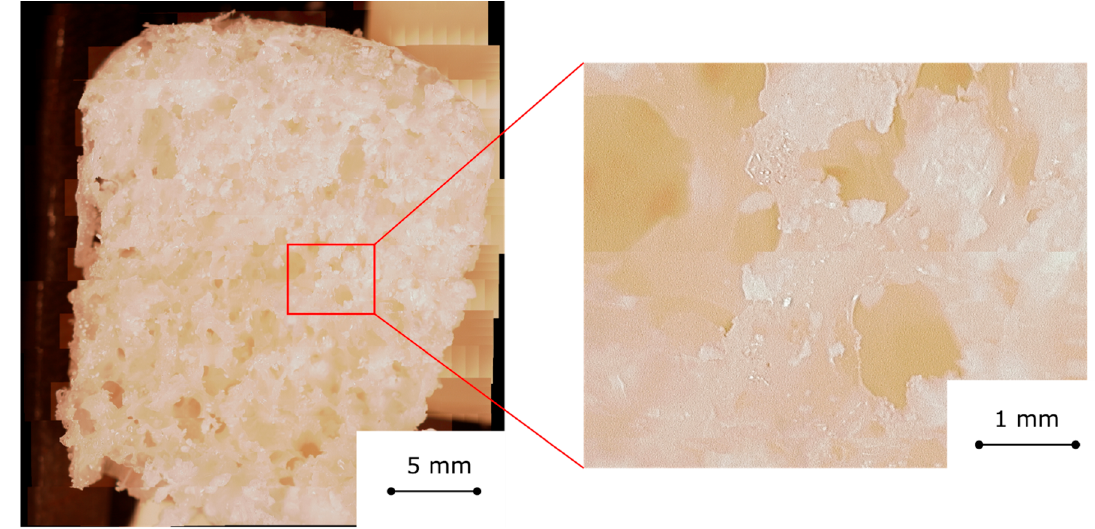
Figure 2. Optical image of the foam cross section of a FOAM60 sample.